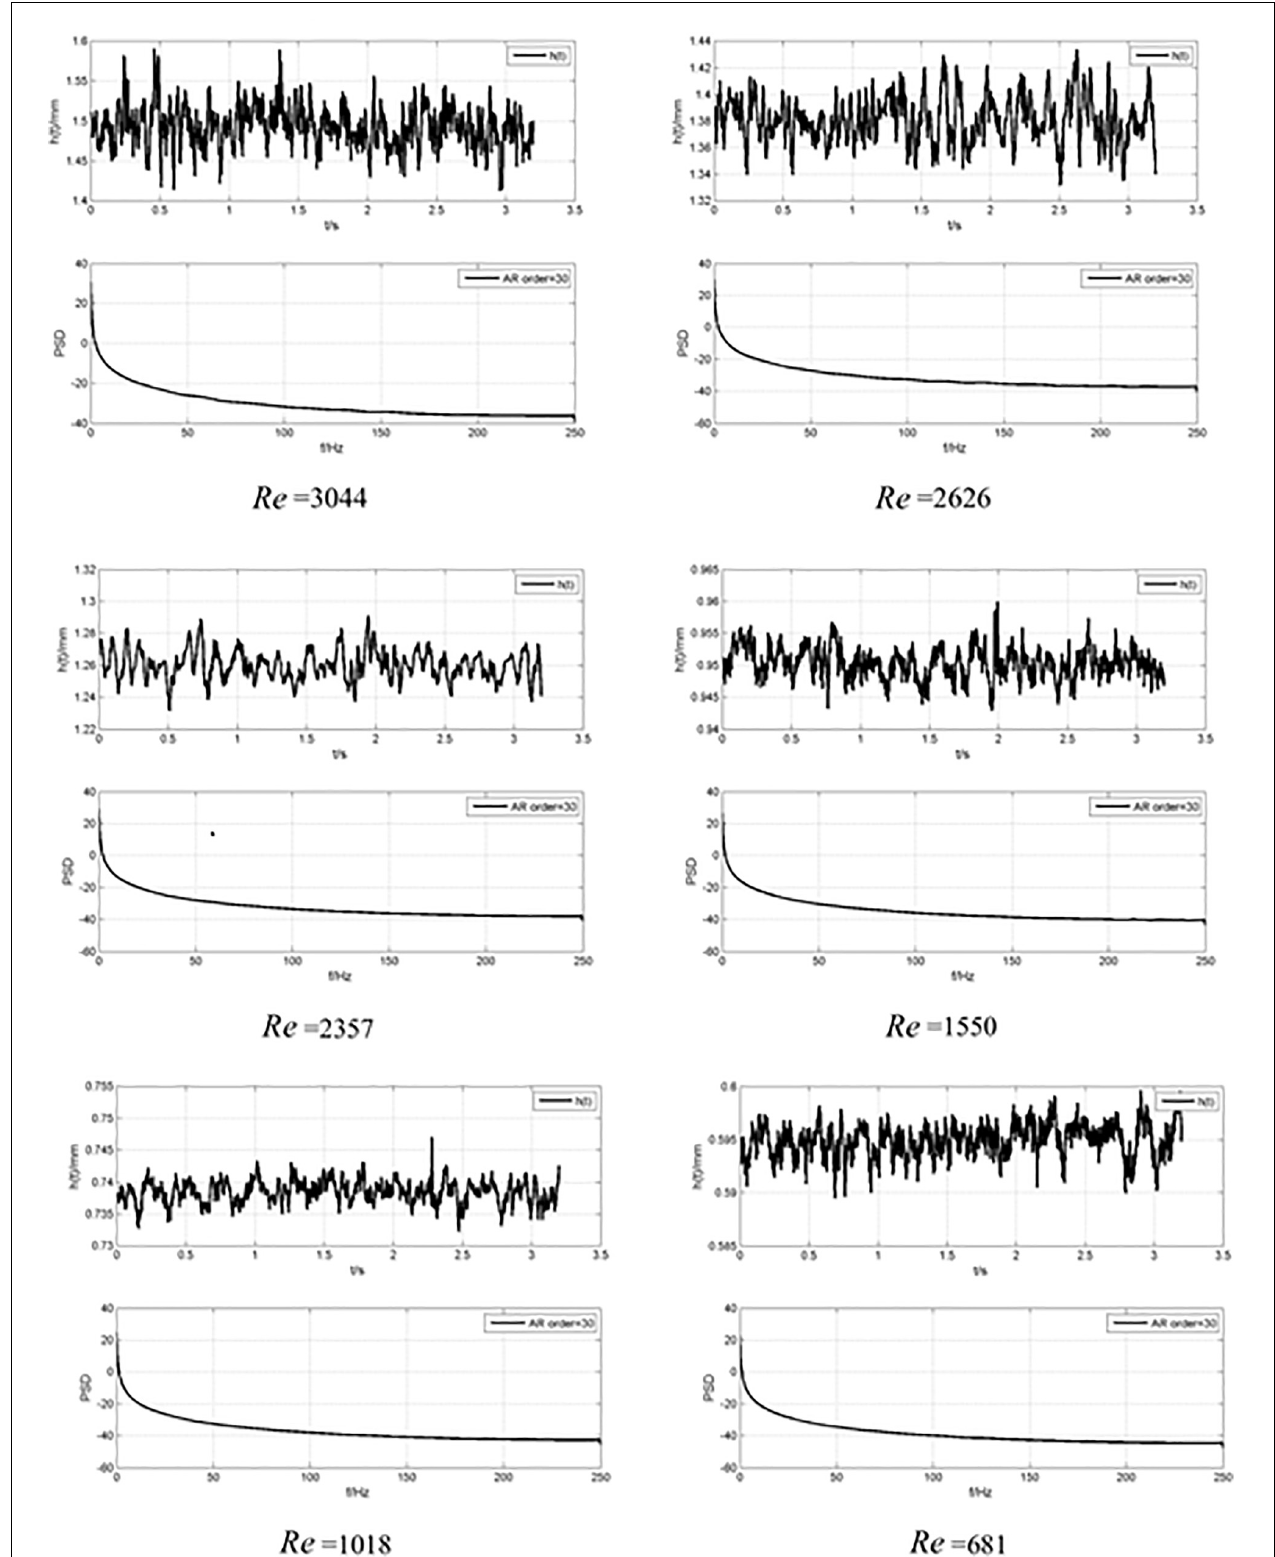
FIGURE 6 | Transient value of liquid film thickness and PSD